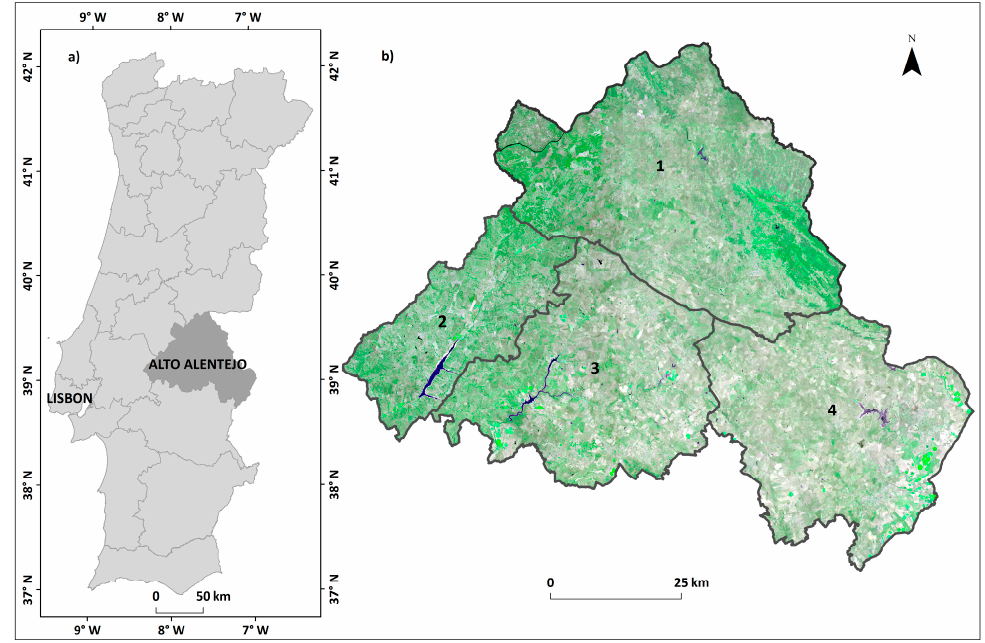
Figure 1. Portugal administrative division NUTIII, Alto Alentejo, ( a ) and false colour composite of Sentinel 2 image (RGB-b483) with homogeneous sub-regions delimited with grey lines ( b